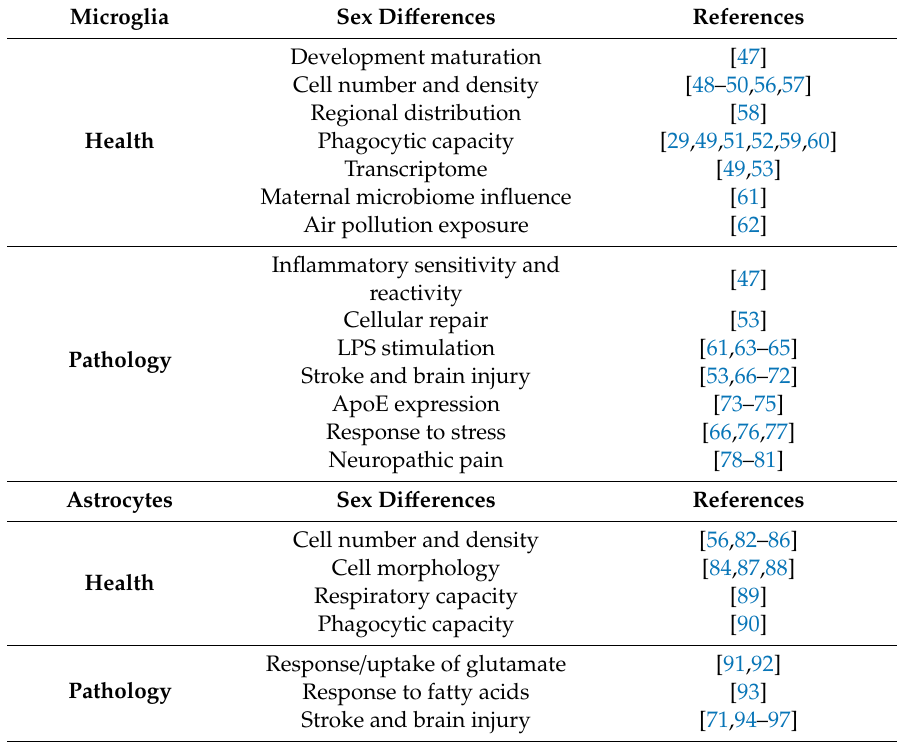
Table 1. Sex di ff erences in microglia and astrocytes in health and pathology with